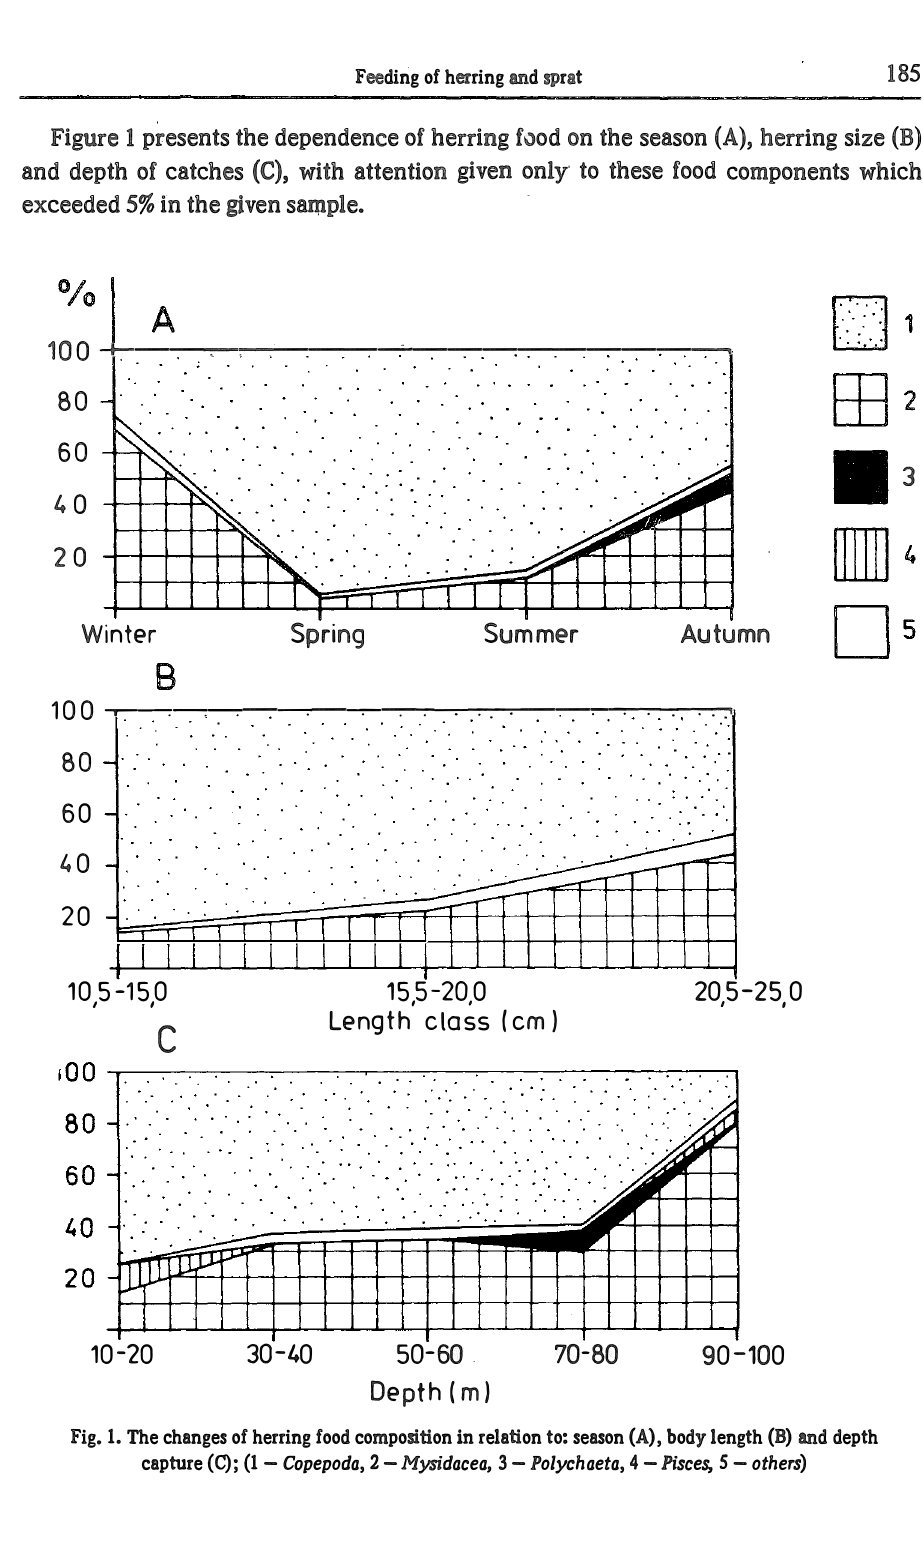
Fig. 1. The changes of herring food composition in relation to: season (A), body length (B) and depth capture (C); (1 -Copepoda, 2-Mysidacea, 3 -Polychaeta, 4 -Pisces, 5